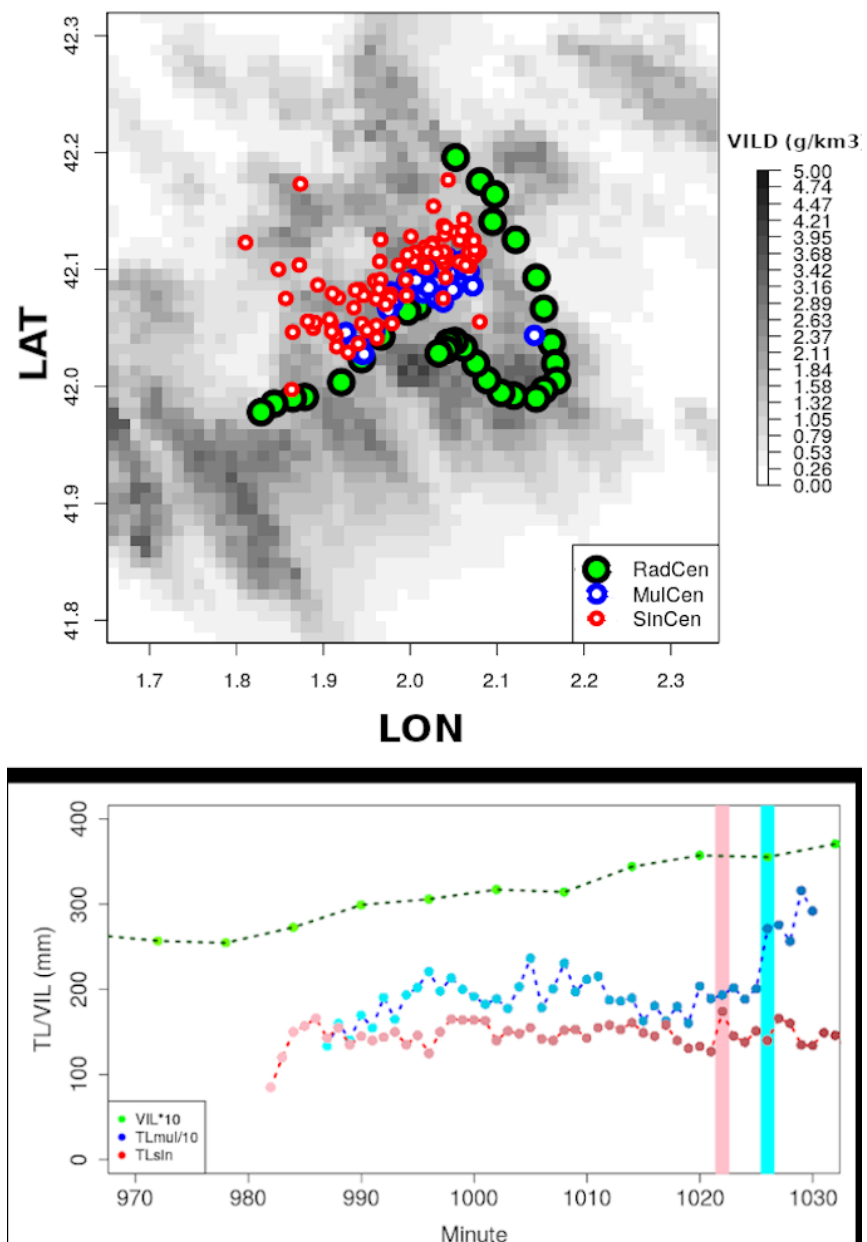
Figure 5. ( Above ) Partial tracking of the same thunderstorm presented in Figure 4, but considering the radar information (green points), the single-TL information (red dots), and the multiple-TL data (blue points). ( Below ) Partial life cycle of the same thunderstorm, showing the VIL evolution (6 min time resolution) and the TL with single- (red) and multiple- (blue) lightning sources. The vertical lines indicate the time of occurrence of the two